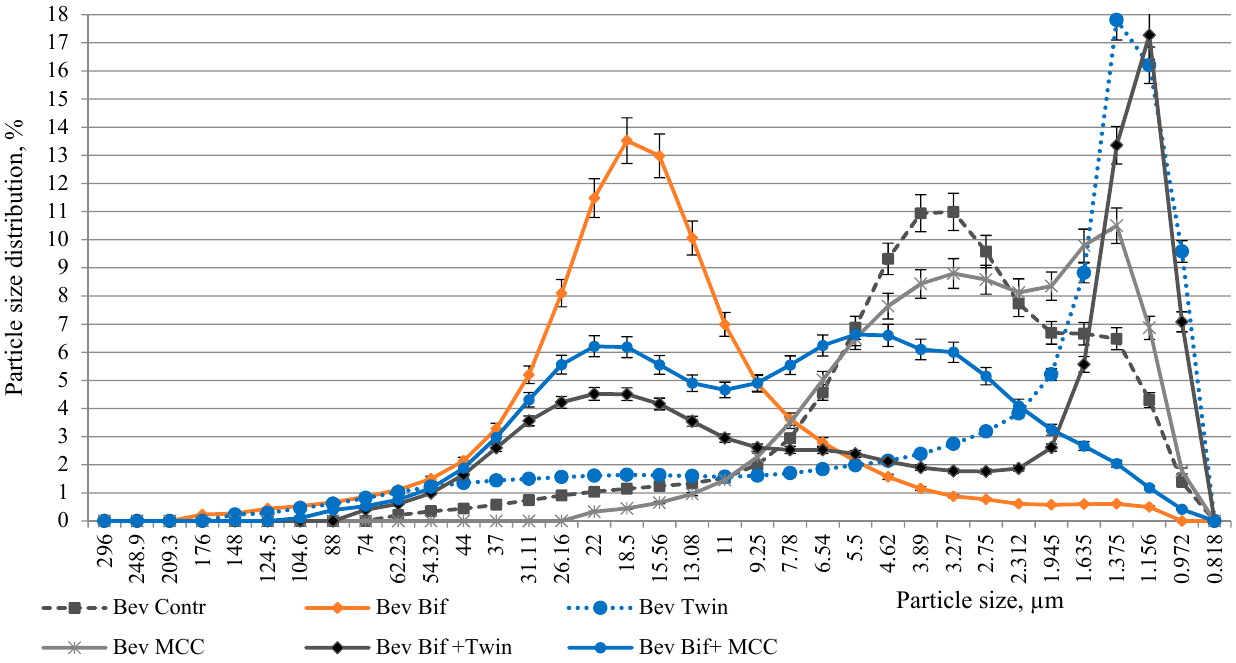
Figure 4. Particle size distribution for microemulsion-stabilized plant beverages. The error bars represent the standard deviation of measurements ( n = 5). Designation of samples: Bev Contr—unfermented beverage from hemp seeds, Bev Bif—beverage from hemp seeds, fermented by Bifidobacterium longum ; Bev MCC (Bev Twin)—unfermented beverage from hemp seeds, stabilized by microemulsion with microcellulose (twin-80); Bev Bif+ MCC (Bev Bif +Twin)—beverage from hemp seeds, stabilized by microemulsion with microcellulose (twin-80) fermented by Bifidobacterium longum